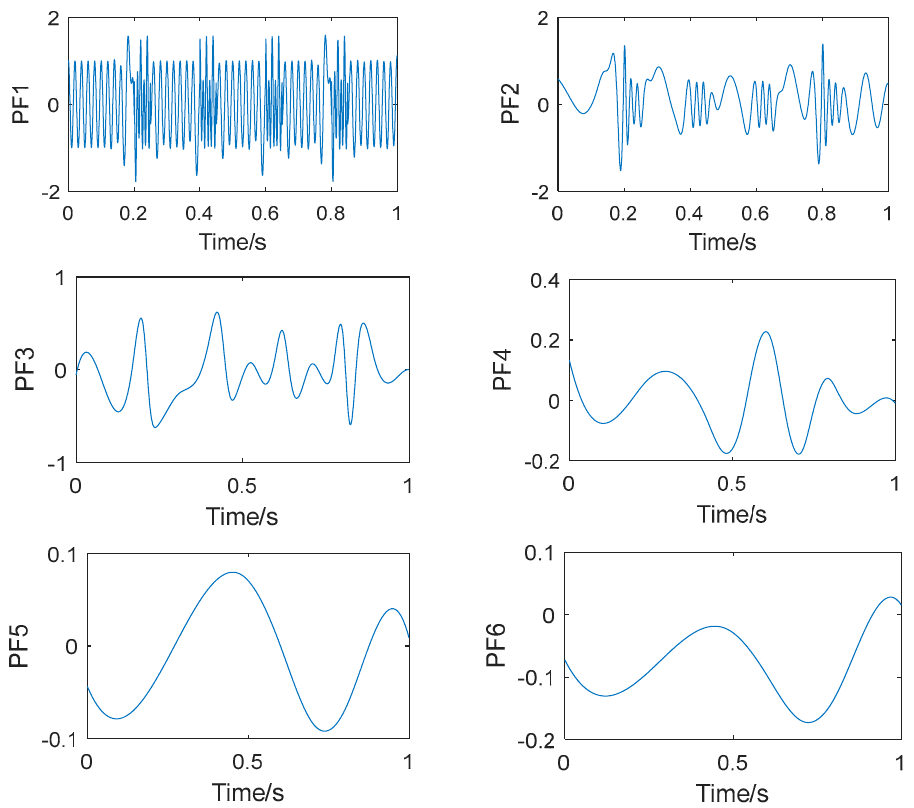
Figure 5. Simulation signal y ( t ) local mean decomposition (LMD) result. PF (Product function).